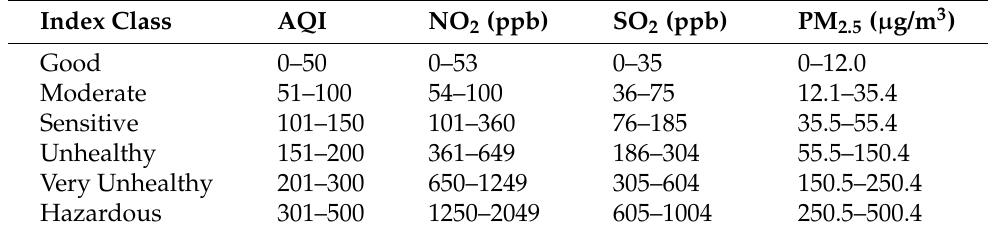
Table 1. The boundary values of the air quality pollutants.